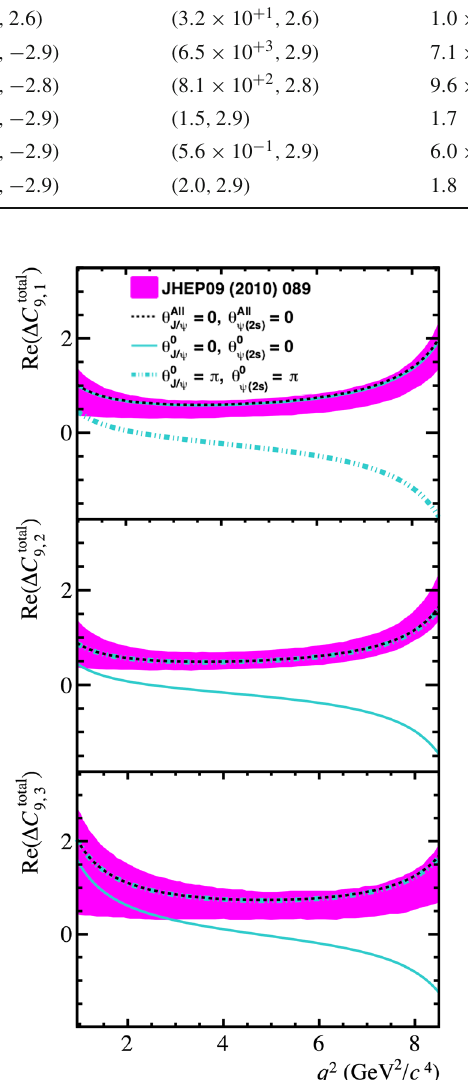
Fig. 1 The non-local contributions to the B 0 → K ∗ 0 μ + μ − invariant amplitudes as a function of q 2 . The prediction using the model dis- cussed in Sect. 2 is shown, where only the contributions from the J /ψ and ψ( 2 S ) resonances are considered. The free phases θ 0 are both set to 0 (cyan solid line) or π (cyan dashed-dotted line). The predictionwhereallphasesofthe J /ψ and ψ( 2 S ) appearinginEqs.7–9 aresettozeroisalsodepicted(blacksolidline),alongsidetheprediction from Ref. [28] (magenta